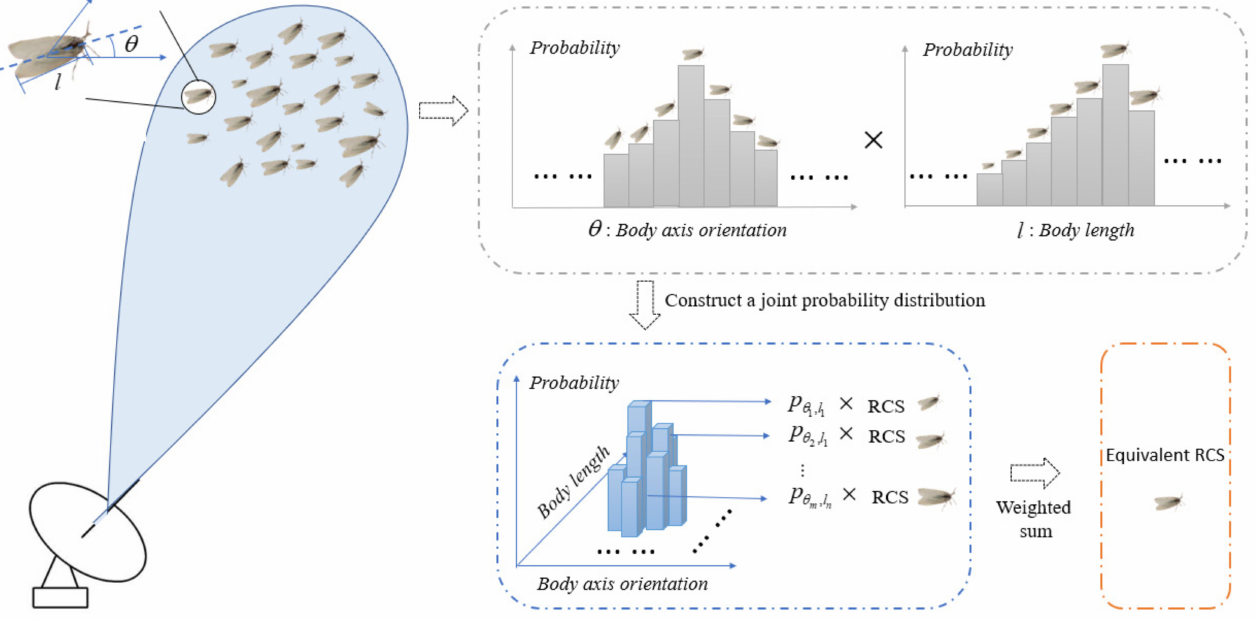
Figure 8. Schematic diagram of the insect-equivalent RCS